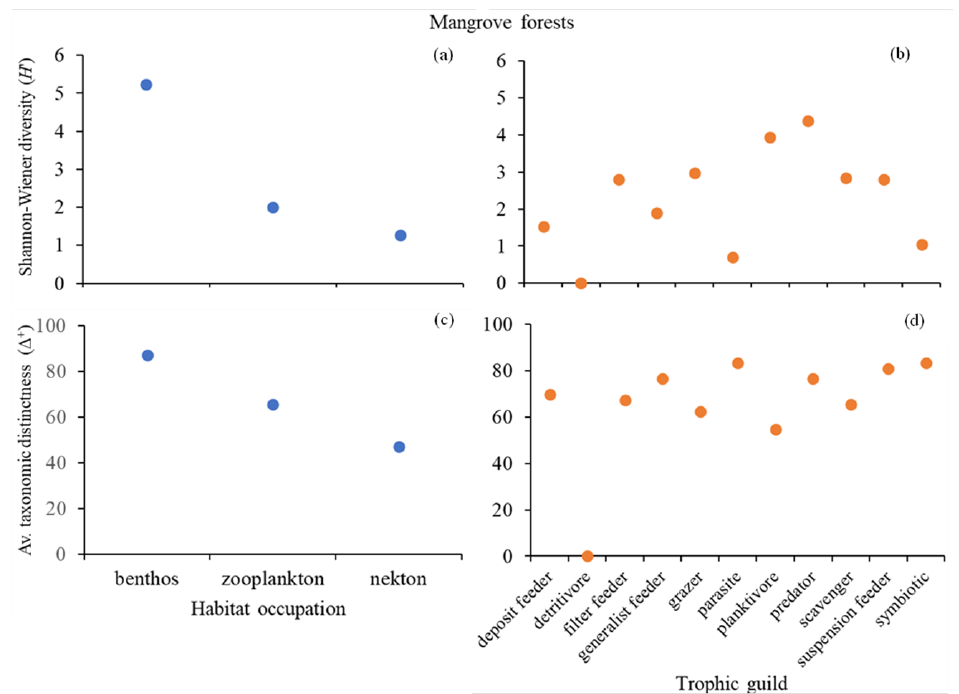
Figure 5. Community composition of mangrove forests in Maputo Bay. Shannon–Wiener diversity index (H’) regarding ( a ) habitat occupation (HO) and ( b ) trophic guild (TG). Average taxonomic distinctness index ( ∆ +) regarding ( c ) HO and ( d ) TG. (Note: all values indicated in the graphs as 0 are due to the low number of occurrences).